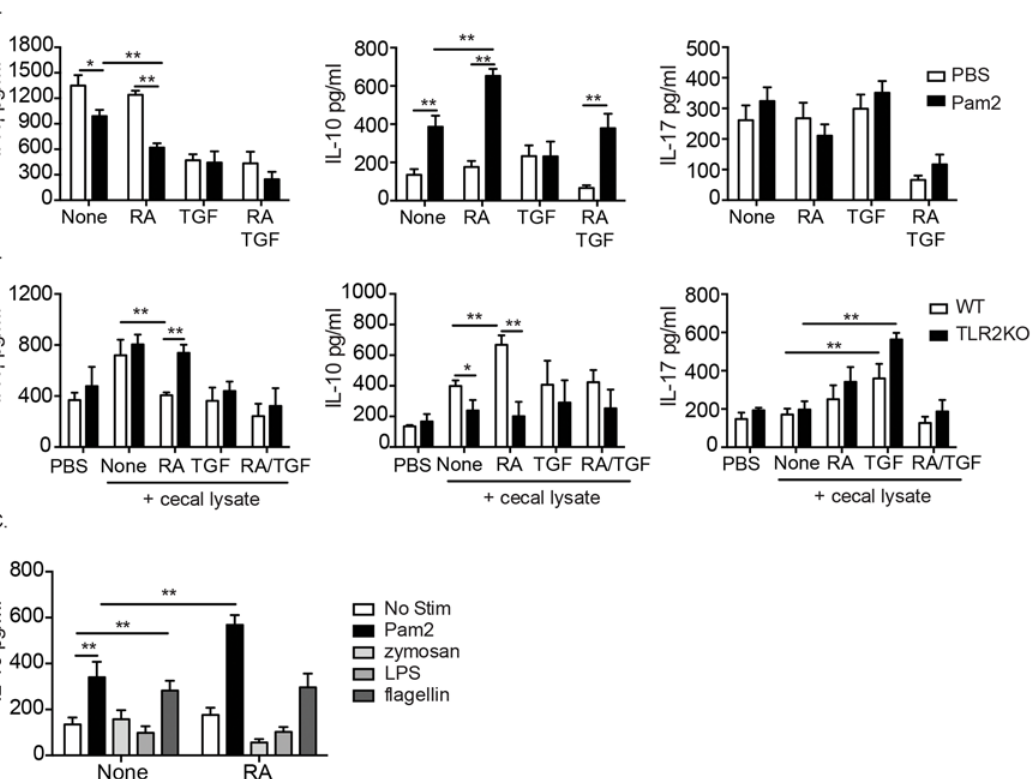
Fig 4. RA and TLR2 signals suppress pro-inflammatory cytokines from T cells. Cytokine production from purified splenic CD4 + T cells stimulated with anti-CD3 ε and (A) Pam2CysK4, (B) cecal lysate, or (C) indicated TLR agonists in the presence or absence RA, TGF- or RA/TGF- β . Data are the mean ± SEM of 3 – 4 independent experiments. * , p < 0.05, ** , p < 0.01 using Student ’ s